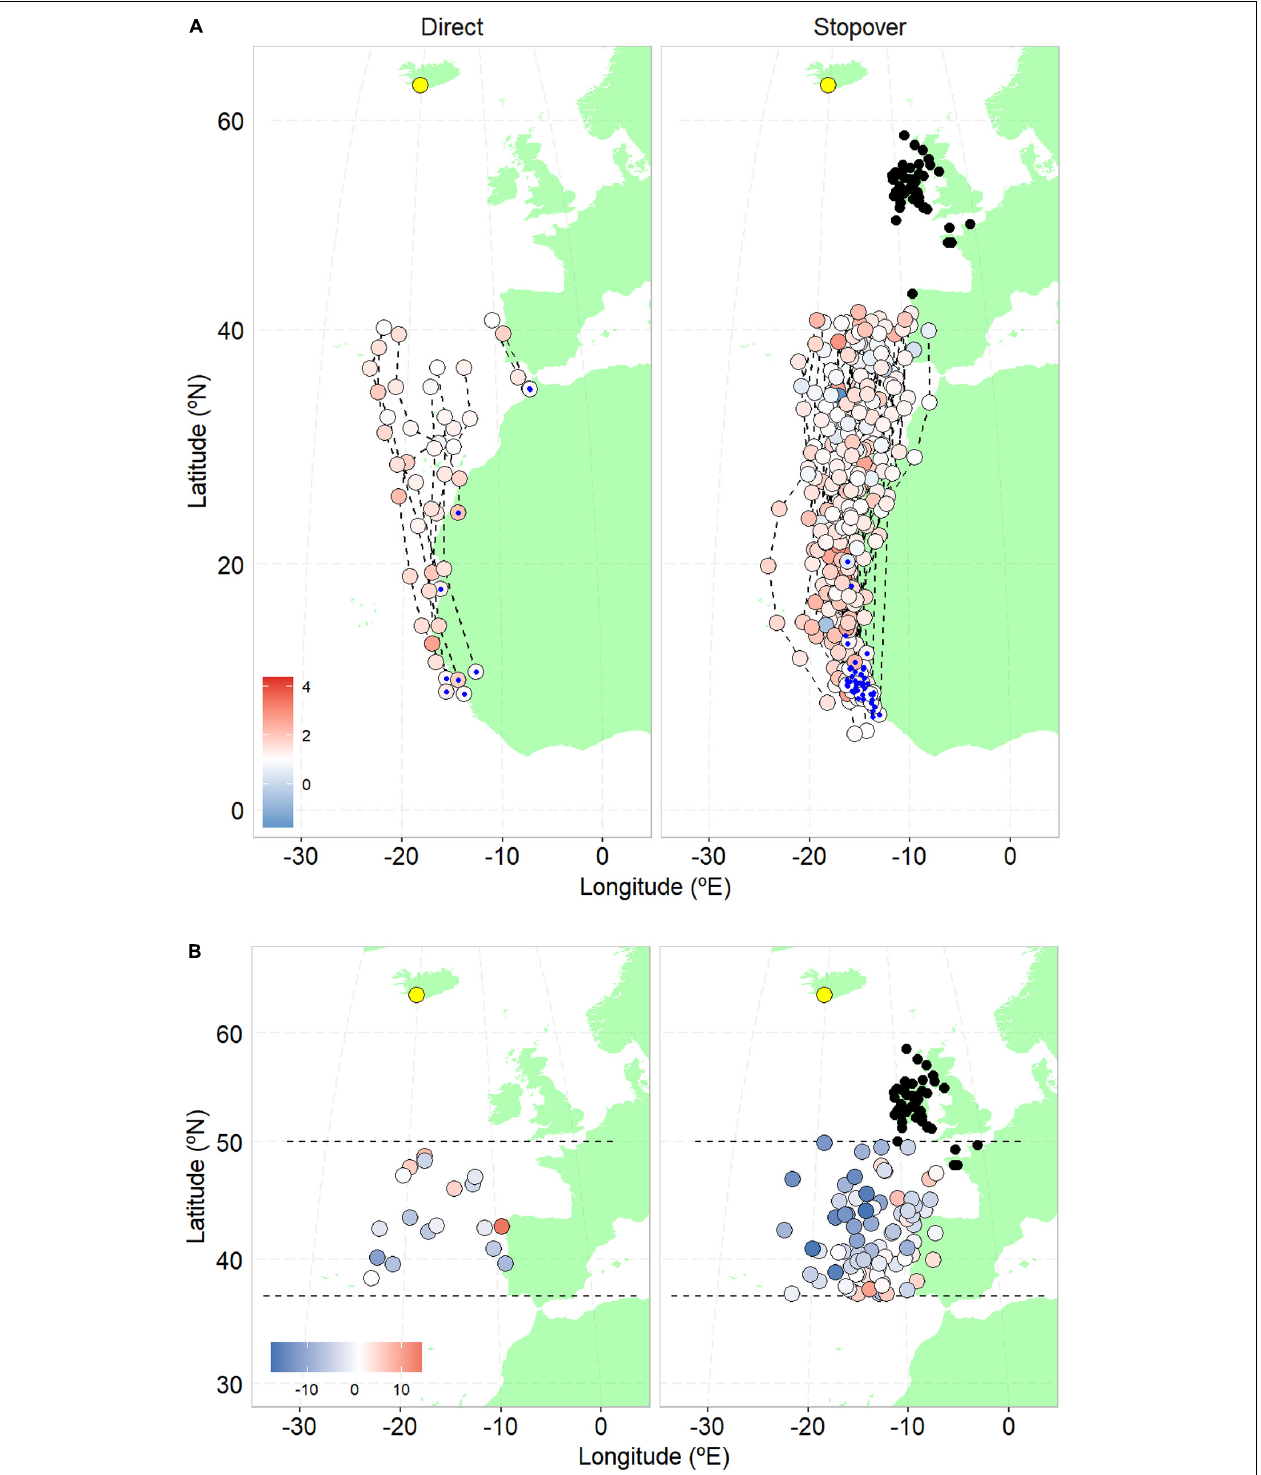
FIGURE 1 | (A) Spring migration locations recorded with geolocators up to latitude 42 ◦ N, colored by air-to-ground speed ratio (at 1,000 hPa); blue represents wind support (values below one), whereas red represents wind impediment in the direction of movement (values above one); individual winter locations are given as blue dots. (B) Locations during spring migration between latitude 37 and 50 ◦ N, colored by zonal wind (u, in ms − 1 , at 1,000 hPa), where blue (negative) values represent westward winds and red (positive) values eastward winds. Circles depict stopover (black) and breeding (yellow) locations. Left panels show locations of individual whimbrels undertaking a direct migration ( n = 9), and right panels a stopover migration ( n = 48).